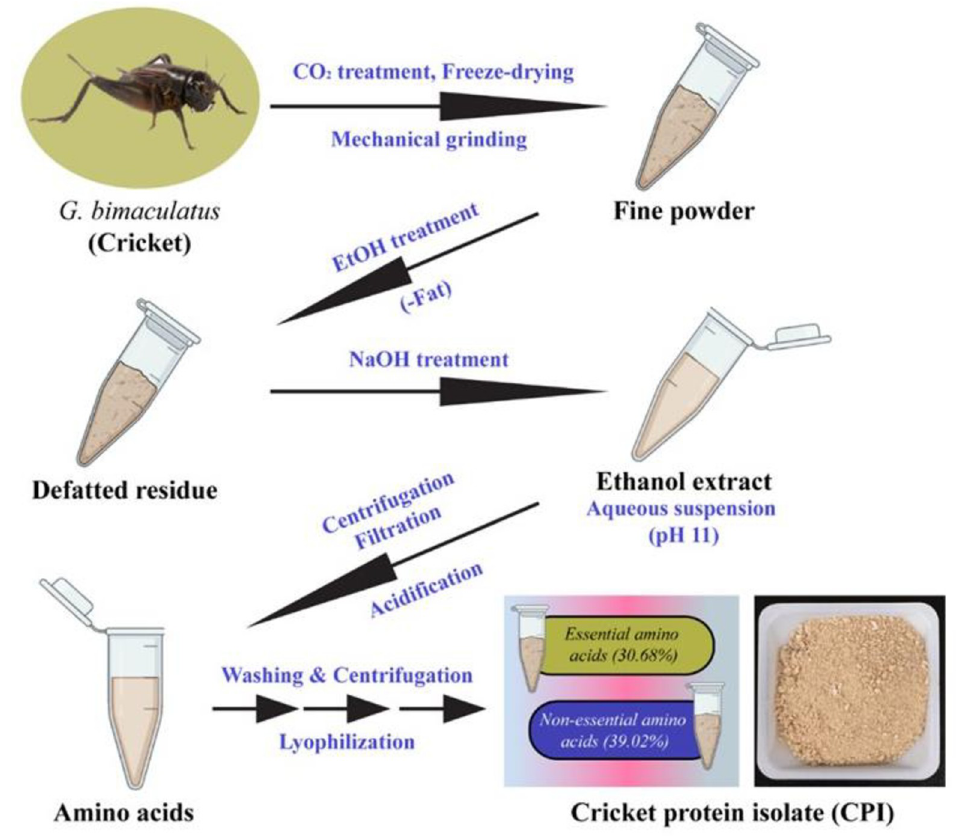
Fig 1. Schematic illustration of protein extraction from Gryllus bimaculatus